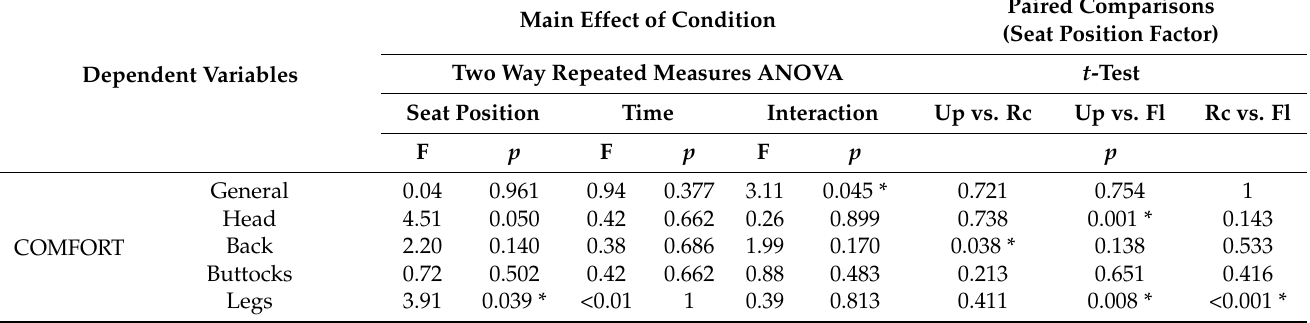
Table 2. ANOVA and t ‐ test paired comparison for dependent variables related to comfort and relax level in the seat for the upright (Up), reclined (Rc) and flat (Fl) conditions. * Symbol indicates a significant effect ( p < 0.05).